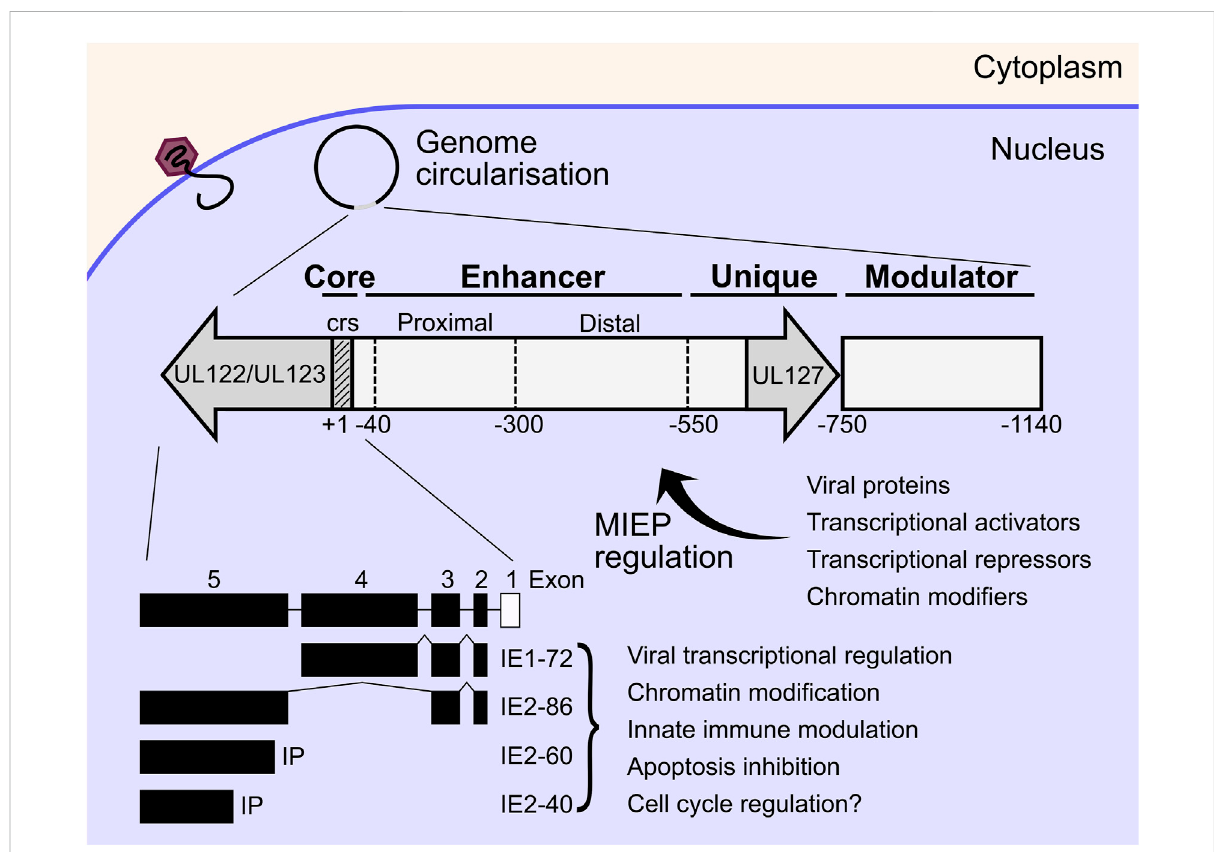
FIGURE 2 Inside the host cell nucleus, viral genomes circularise, and IE gene expressioncommences independently of viral protein synthesis. The MIEP is immediately upstream ofthe IE genes and acts as ahub for transcriptional activation or repression of theIE proteins by diverse host and viral factors. MIEP regulation also dictates the switch from lytic replication to latency and vice versa . The MIEP begins immediately upstream of the UL122/UL123 ORF and consists of the core (+1 to − 40), enhancer ( − 40 to − 550), unique ( − 550 to − 750) and modulator ( − 750 to − 1,140) regions. The IE1 and IE2 proteins are the main IE effectors which are encoded by the UL122/UL123 ORF by alternative splicing. IE1-72 and IE2-86 are multifunctional proteins that transactivate DE viral genes, remodel chromatin, disrupt interferon signalling, and inhibit apoptosis to create a conducive cellular environment for viral replication. IE, immediate early; MIEP, major immediate early promoter; ORF, open reading frame; DE, delayed early; crs, cis - repression